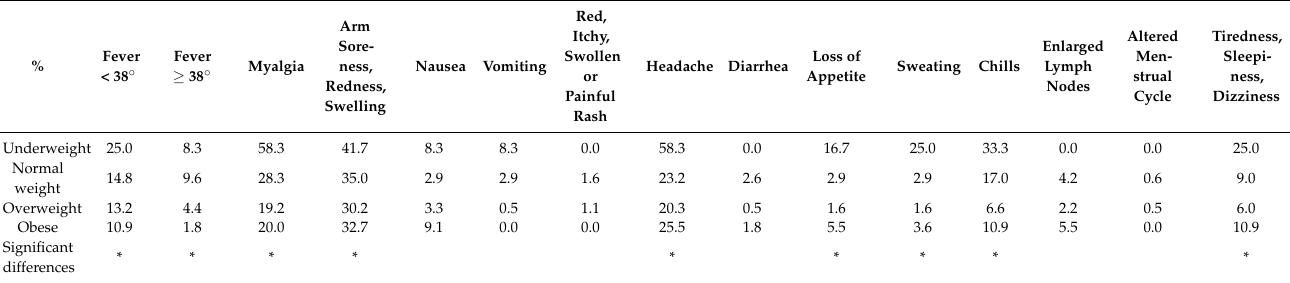
Table 4. Cross tabs of side effects after receiving the second dose of the vaccine against COVID-19 (N = 590) per weight status (in percentage).